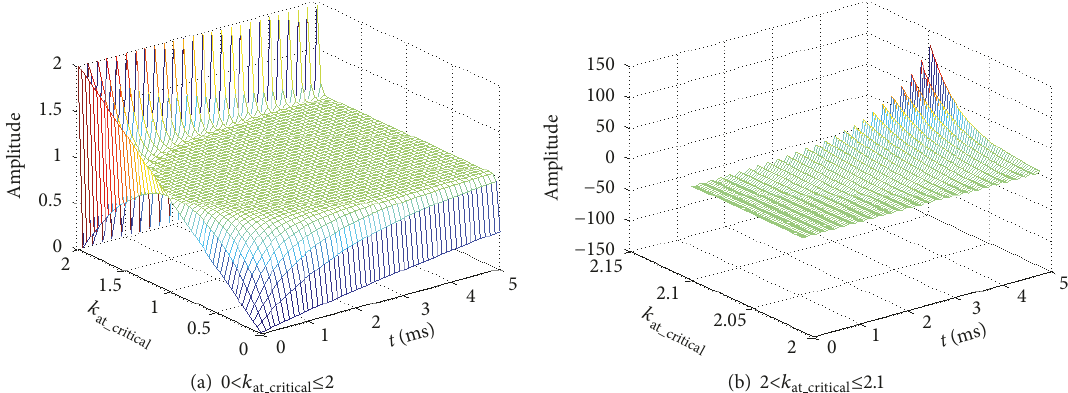
=10kHz and resistance r =0.01 when s